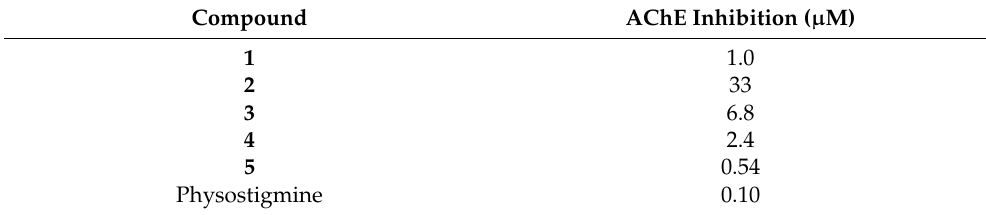
Table 1. IC 50 of 1 – 5 against AChE in µ